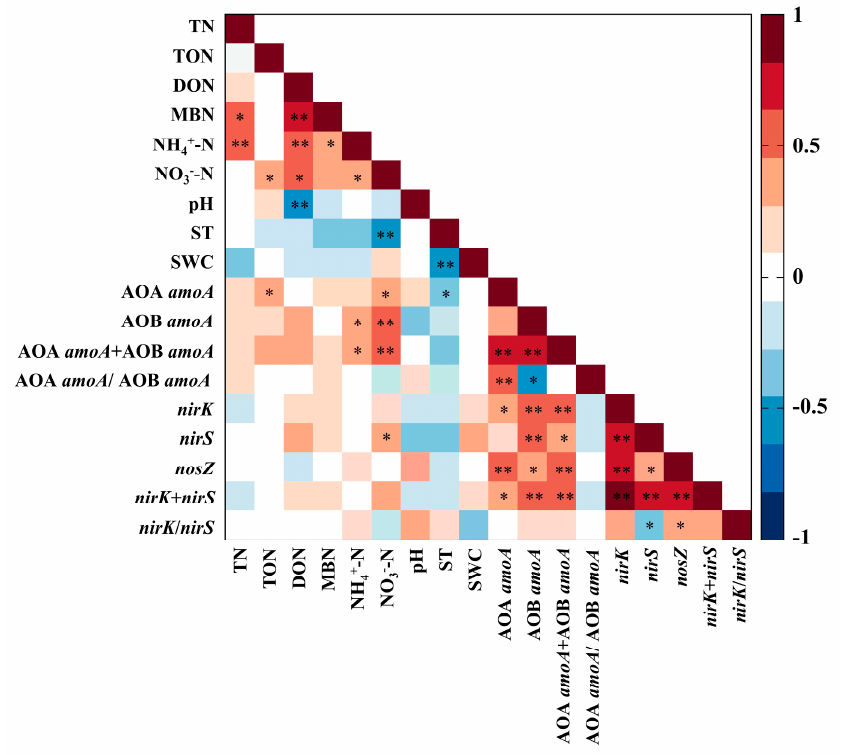
Figure 3. Pearson correlation between gene abundance and soil physical and chemical properties.